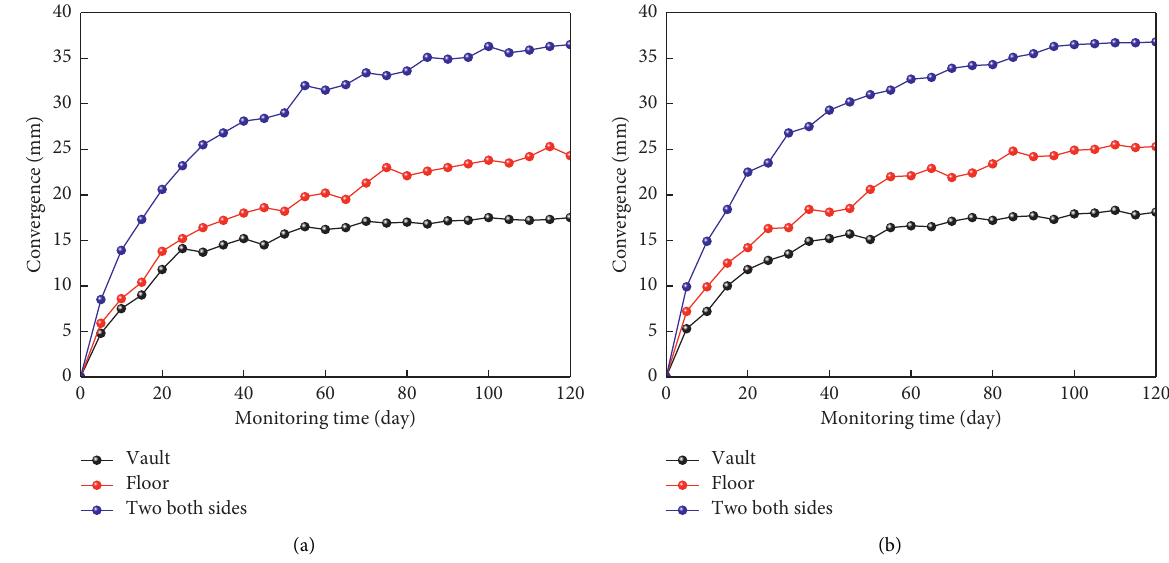
Figure 14: Field application monitoring results. (a) Monitoring results of station #1. (b) Monitoring results of station